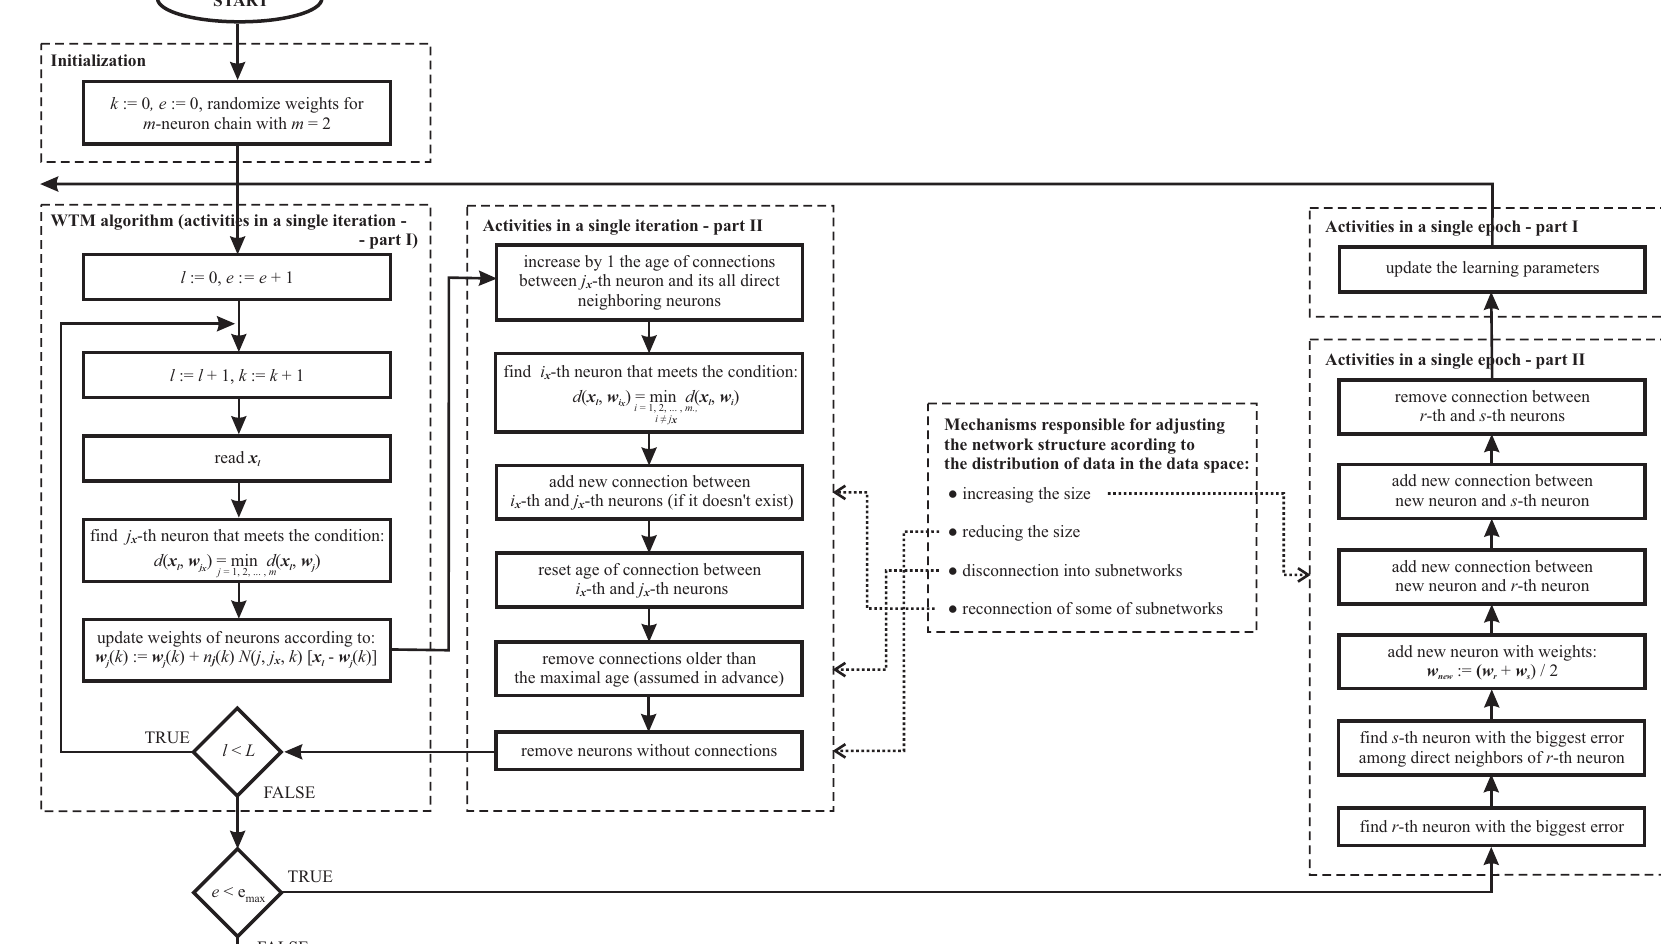
Figure 3. Block scheme of the learning algorithm of